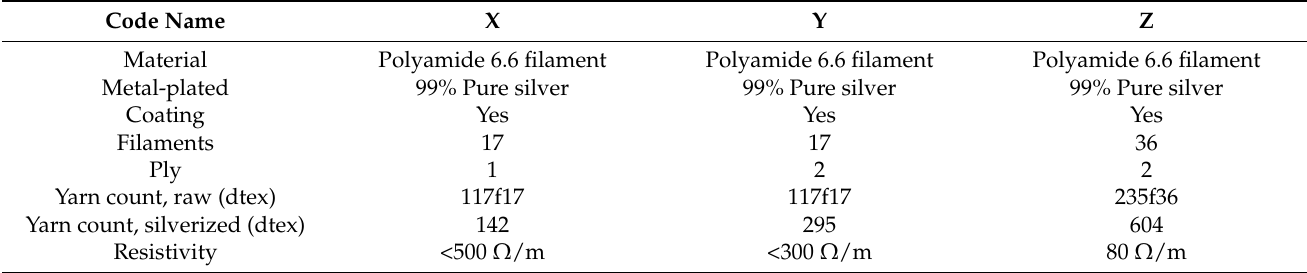
Table 1. Characteristics parameters of the ECYs.